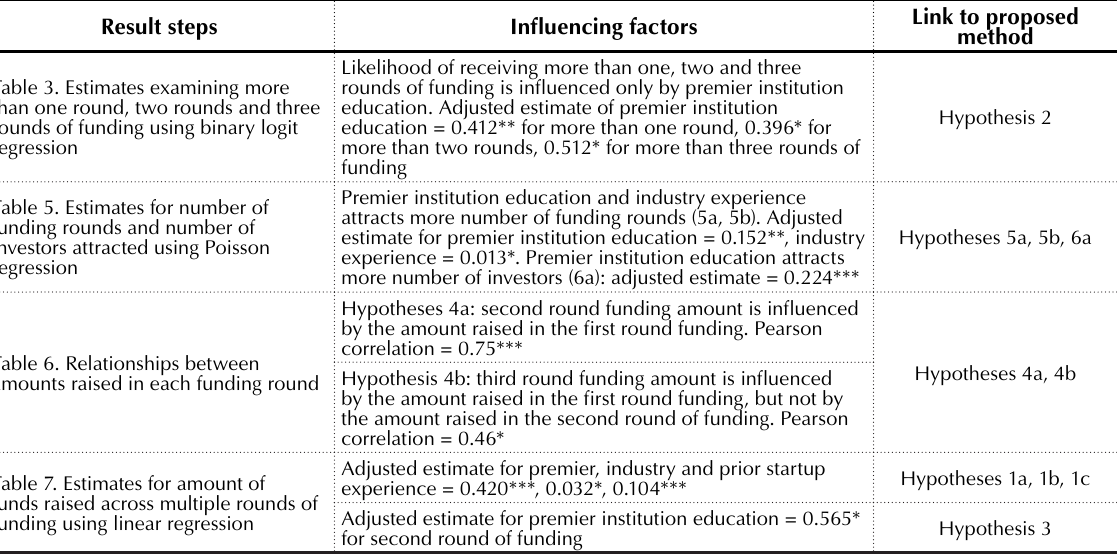
Table 7. Estimates for amount of funds raised across multiple rounds of funding using linear